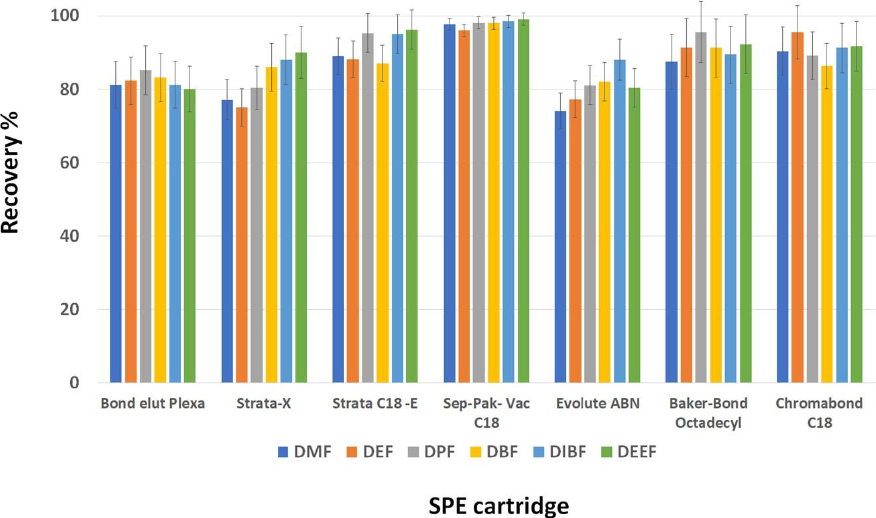
Figure 1. Comparison of SPE cartridges on the recovery of standard solutions containing the investigated phthalates at a concentration of 1.0 µg/mL.